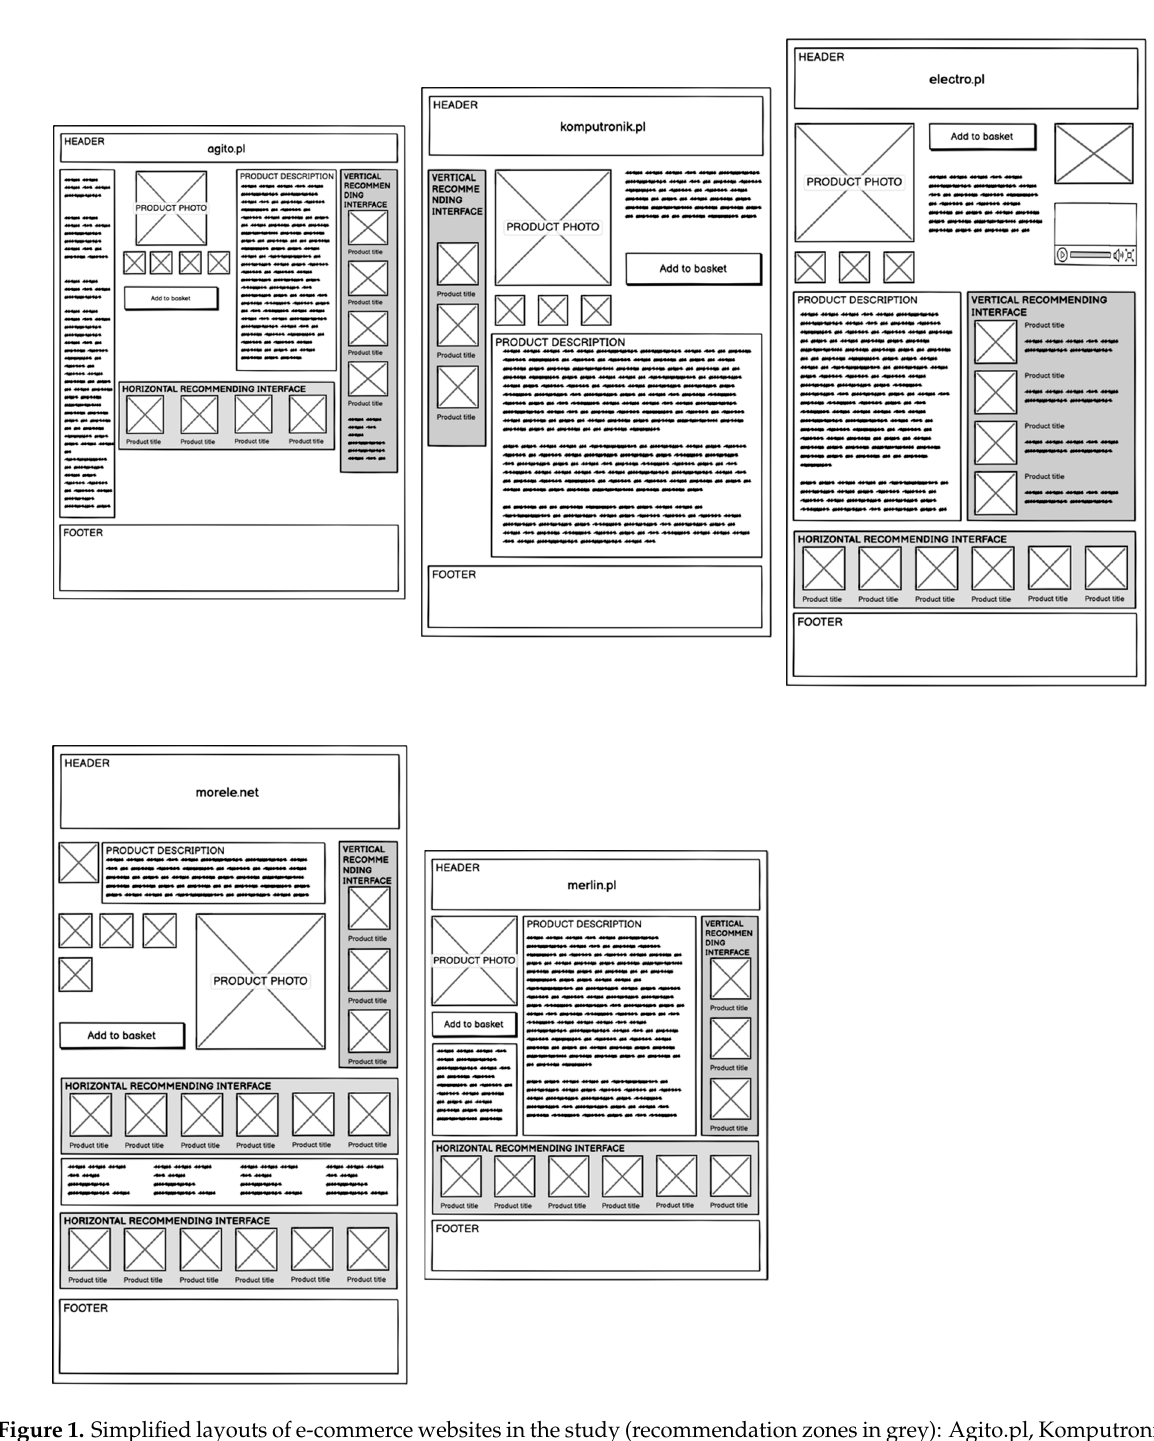
Figure 1. Simplified layouts of e-commerce websites in the study (recommendation zones in grey): Agito.pl, Komputronik.pl, Electro.pl, Morele.net, Merlin.pl.